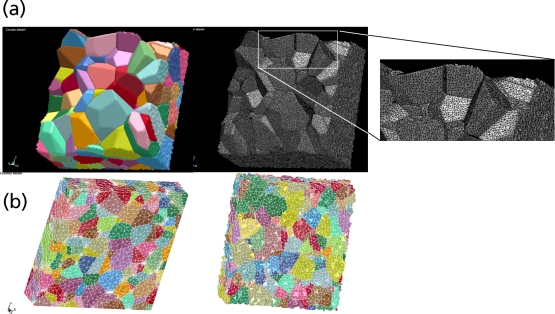
3D structures of a meshed PD. In (a) the granular surface structure, its mesh and a detailed augmented section of the mesh at the surface are displayed. (b) A different realization of a 3D structure displaying the possibility of either leaving a (more realistic) rough surface micro structure, or smoothing the surface and thus obtaining a model body with even surface [168].